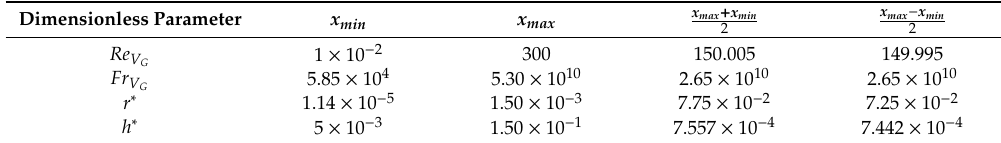
Table 1. Numerical search field for every dimensionless